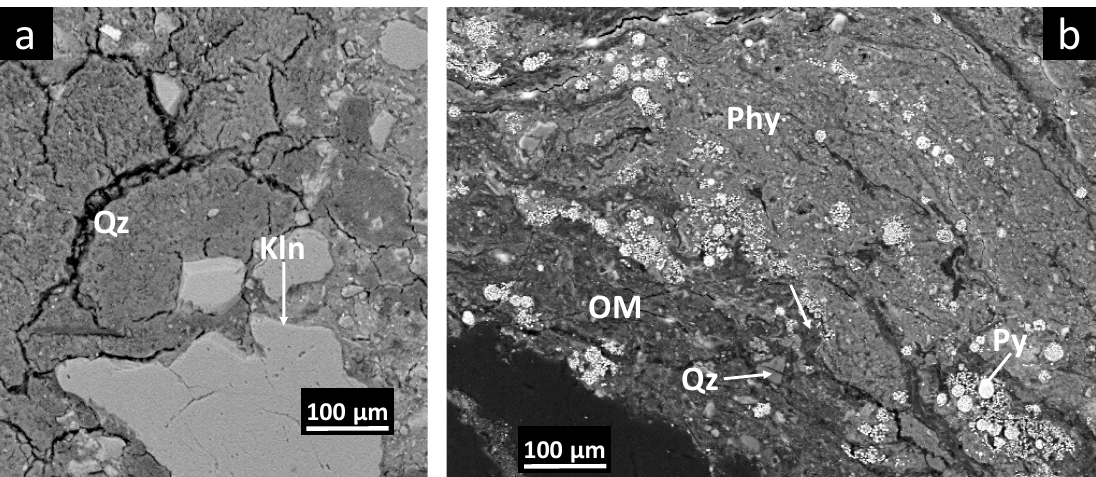
Figure 3. Images of the lake sediments obtained with an electron microscope. ( a ) BSE picture of a southern area of the lake sample, where crystals of quartz in a kaolinite-rich matrix can be seen. ( b ) BSE image of a sample from the north part of the lake, with parts rich in organic matter and framboidal pyrite in a plentiful clay-rich matrix. Phy: phyllosilicates, Kln: kaolinite, Qz: quartz, Py: pyrite, OM: Organic matter.